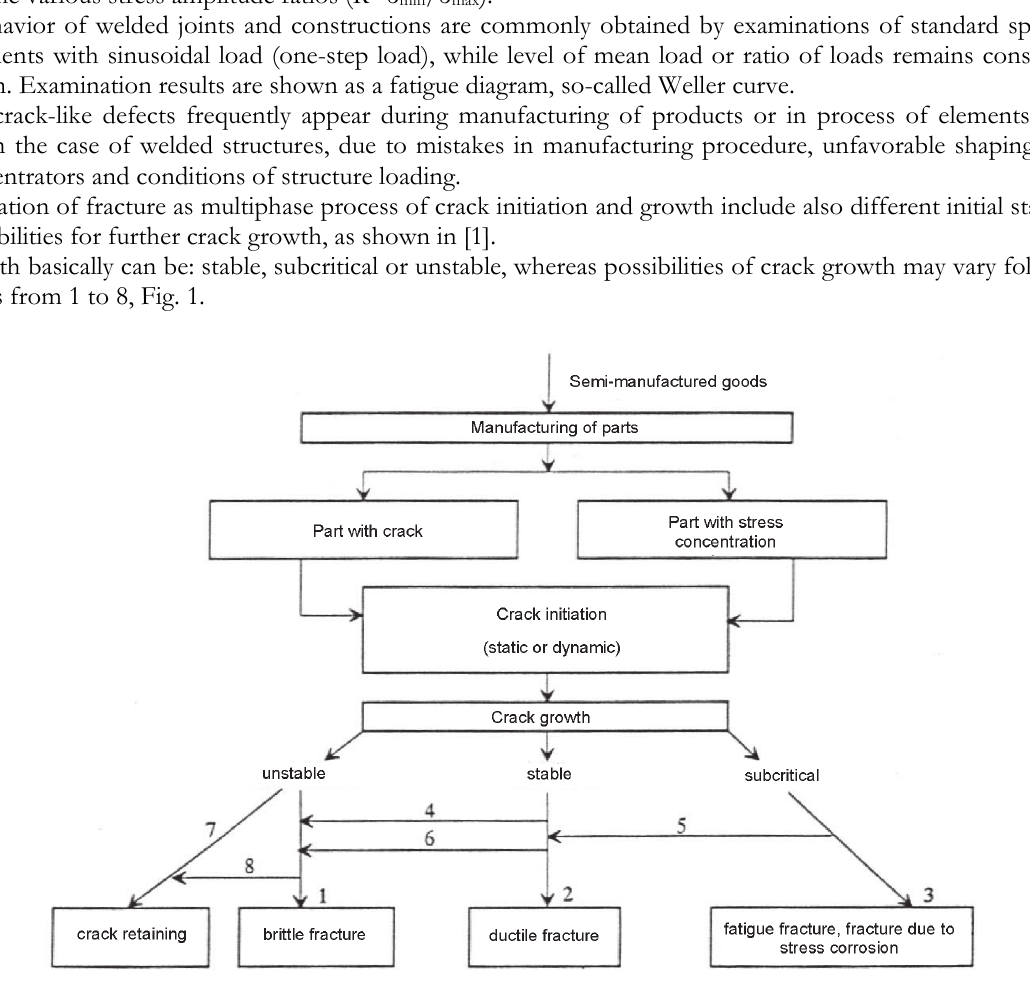
Figure 1: Possibilities of crack